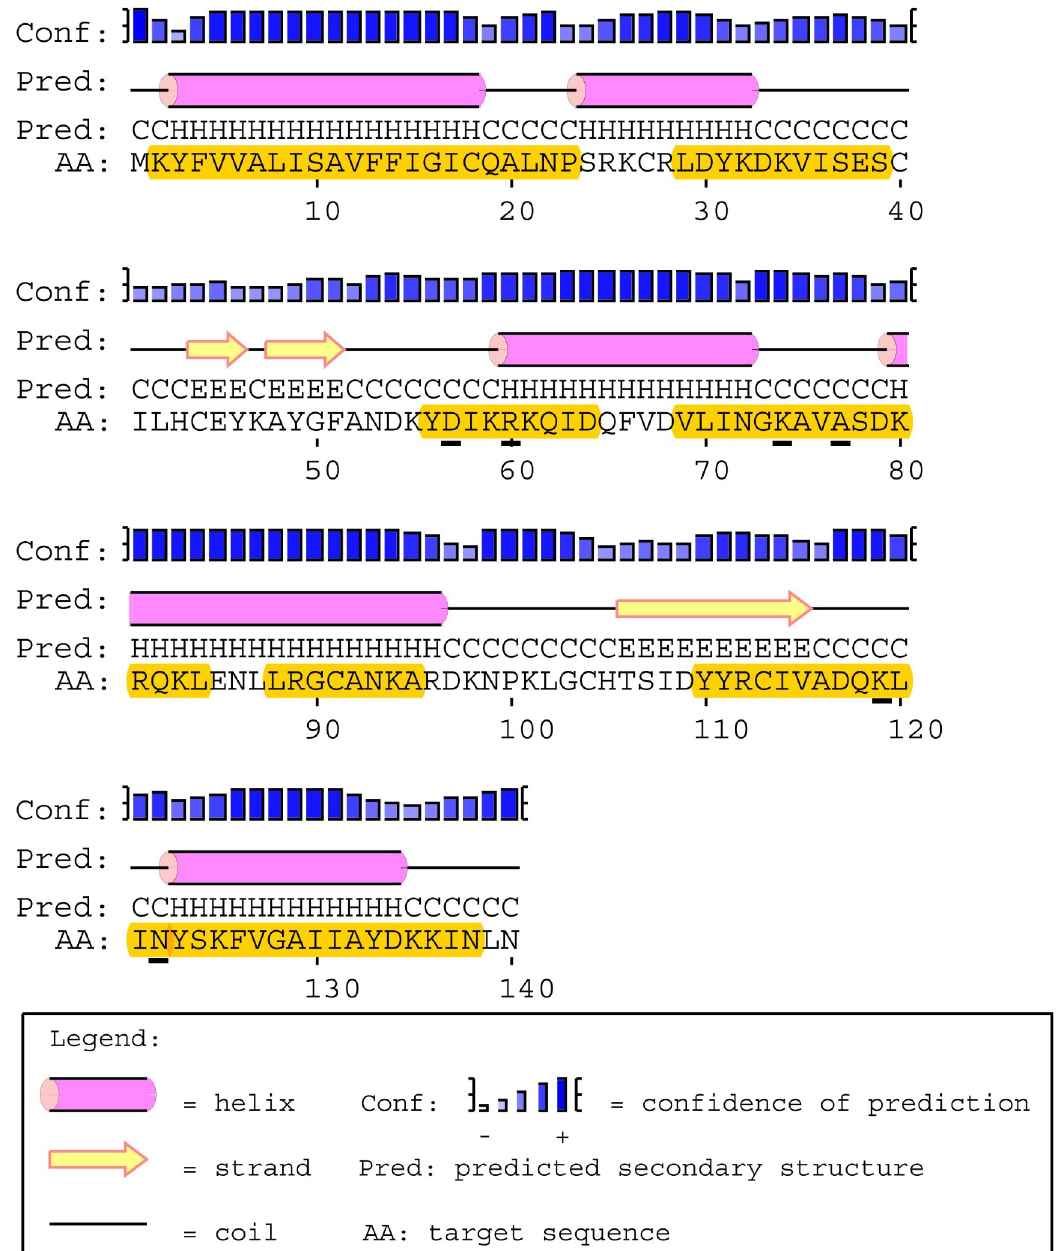
Fig 4. PpSp12 secondary structure, polymorphic sites, and MHC class II epitope predictions. The mature PpSP12 amino acid sequence predicted secondary structure. Yellow highlighted amino acids indicate the predicted MHC class II predicted promiscuous peptides. Individual amino acids underlined in black indicate unique polymorphic sites. Predicted secondary structure based on sequence accession #AGE83083 [51].